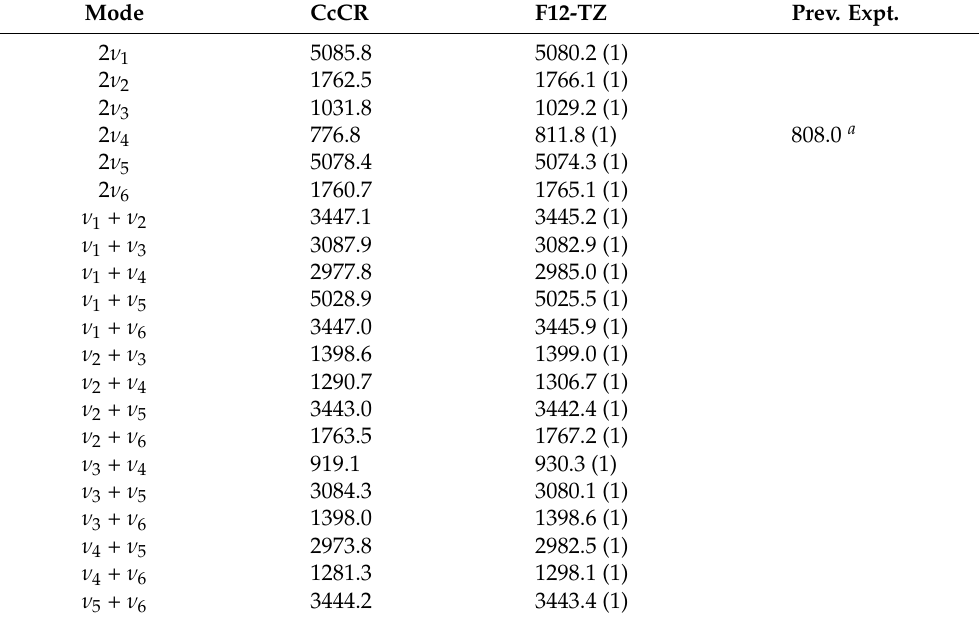
Table 9. Vibrational frequencies (cm − 1 ), and IR intensities (km/mol) given in parentheses for two- quanta bands of HSSH compared to the previous gas-phase